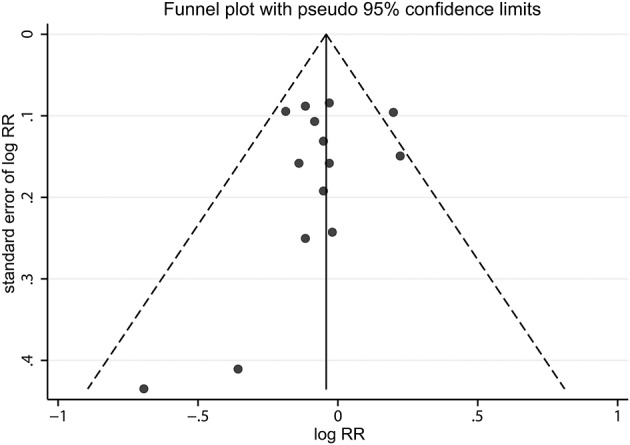
A funnel plot of studies assessing incident venous thromboembolism in highest alcohol consumers compared with the lowest alcohol consumers.